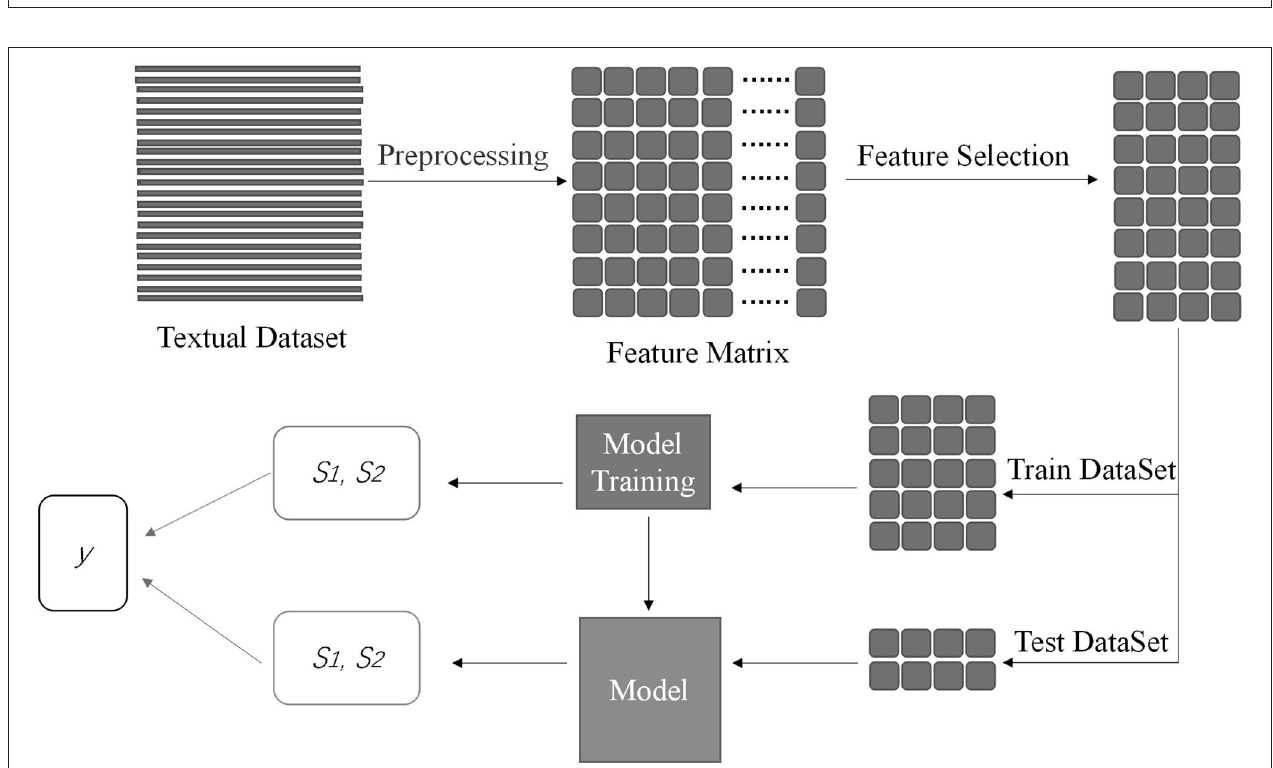
FIGURE 2 | In the figure, the dense bar represents the subject’s text. After the preprocessing, the textual data transforms into feature matrix with a size of n × c , which n is the number of the subjects and c is the number of the corpus. The combined block represents the matrix. Feature selection can extract useful information for classification. Then, divide the matrix into two parts, namely, train and test dataset. Other procedure is similar to Figure 1 . At the end of the procedure, there are two boxes. Two boxes contain S1 and S2 got from train dataset and test dataset. The likelihood ratio y is made up of